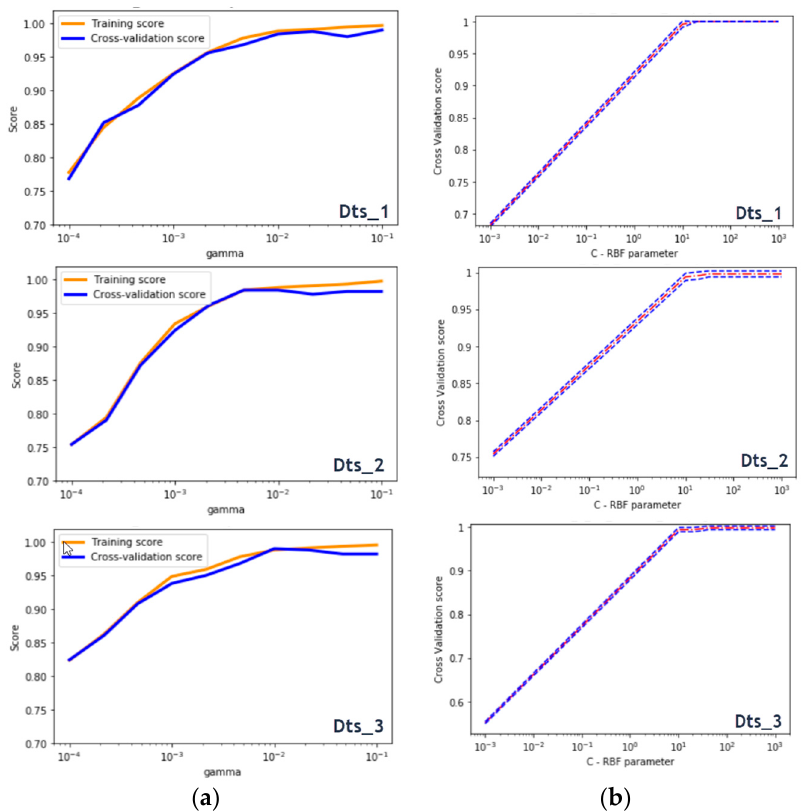
Figure 15. ( a ) Calculations of the best Gamma scores for cross validation and ( b ) calculations of the best C scores for cross validation.